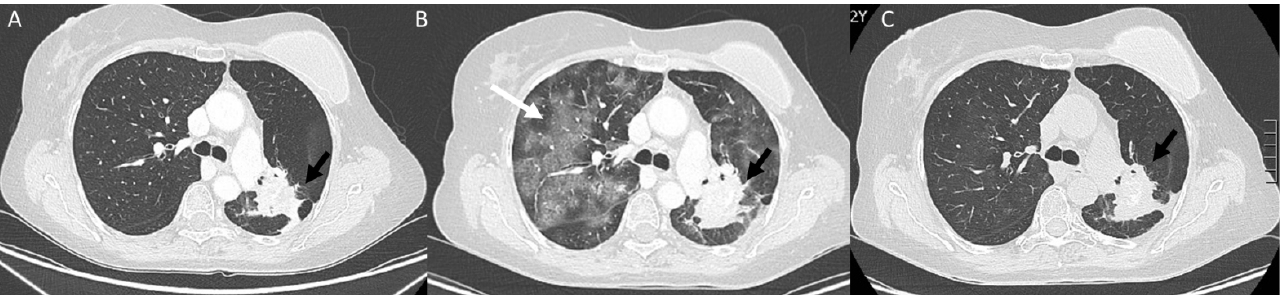
Figure 7. NSLC (black arrows) patient treated with immunotherapy. CT assessment in pre-treatment phase ( A ). During follow-up, in ( B ), appearance of ir-Pneumonitis (white arrow), with disease regression after corticosteroid treatment ( C ).